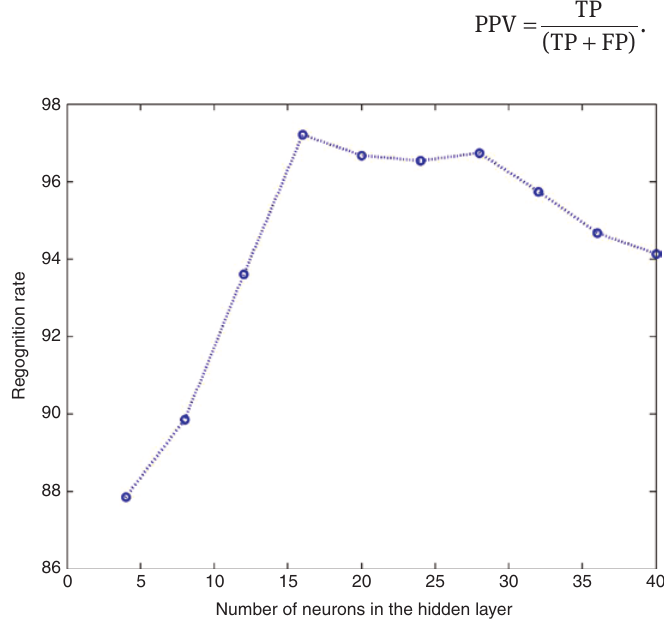
Figure 3. Recognition Rate for Human Skin Based on Hidden